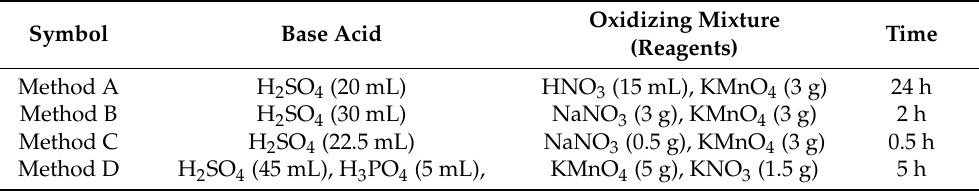
Table 2. GO preparation conditions